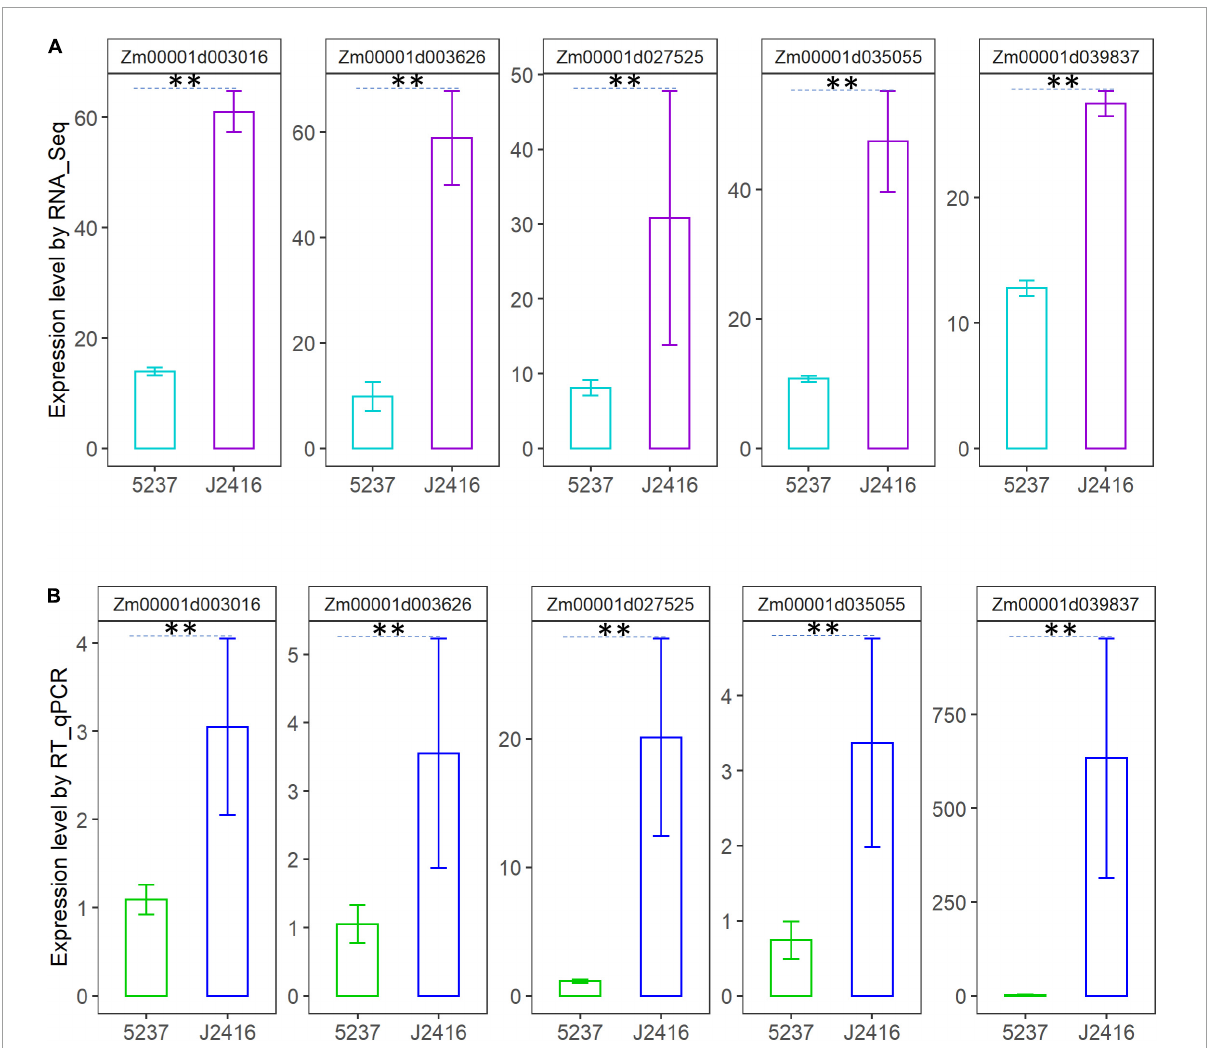
FIGURE6 Expression levels of five randomly selected genes related to cellulose, hemicellulose and lignin in J2416 and 5237. (A) Is the expression level detected by RNA_Seq. (B) Is the expression level detected by RT-qPCR. ∗∗ Means the significant difference at 0.01 level.